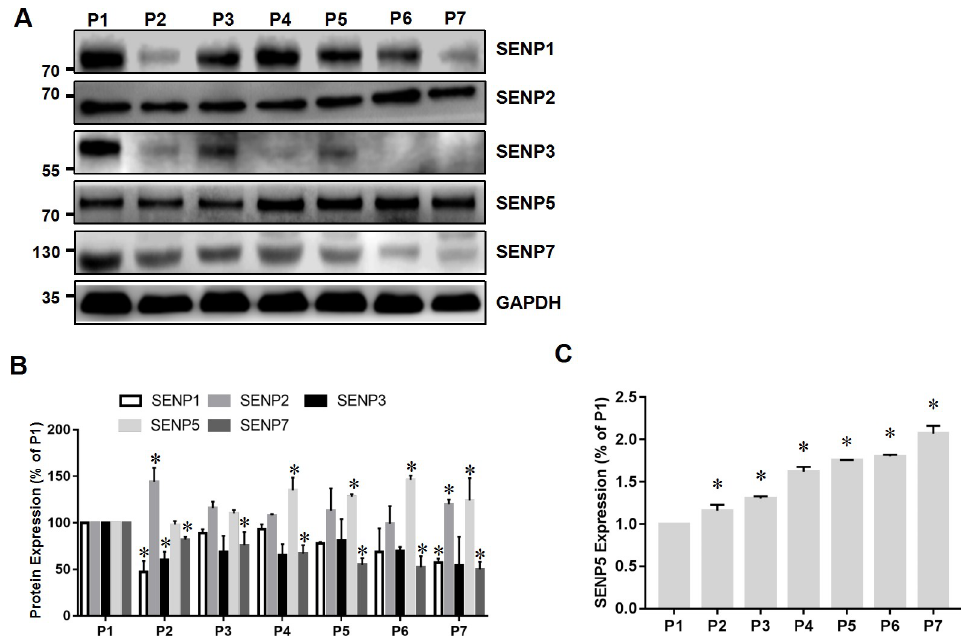
Fig 3. Spatiotemporal distribution characteristics of SENP family members during development of newborn mice. (A) Western blotting of SENP1, SENP2, SENP3, SENP5, and SENP7 protein expression from P1 to P7 (n = 6). (B) Quantitative analysis of SENP protein expression in (A). Values are presented as the mean ± SD. Statistical significance was analyzed using Tukey’s test. � P < 0.05 vs. P1. (C) Expression of SENP5 protein from P1 to P7. Values are presented as the mean ± SD. Statistical significance was analyzed using Tukey’s test. � P < 0.05 vs.